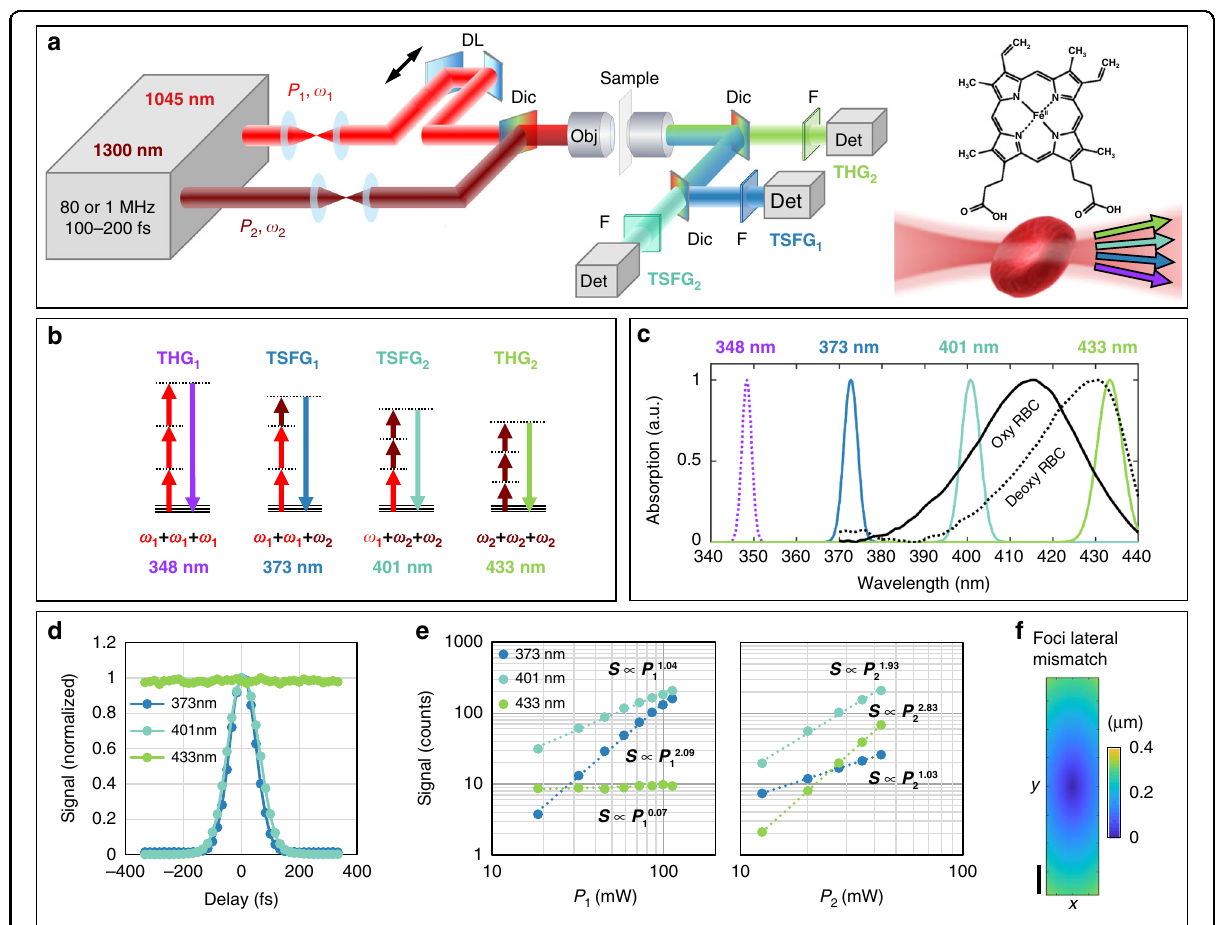
Fig. 1 Principles of color TSFG microscopy for blood imaging. a Experimental setup. DL: motorized optical delay line. Dic: dichroic mirror. Obj: objective lens. F: spectral bandpass fi lter. Det: detector. b Energy diagram of the simultaneous signals processes in color TSFG microscopy, based on third-order combinations of two excitation beams at frequencies ω 1 and ω 2 . The wavelengths indicated are those produced in the case of mixed 1045 and 1300 nm excitation. c Measured linear absorption spectra of zebra fi sh RBCs in deoxygenated (dotted line) and oxygenated (solid line) states. The wavelengths generated simultaneously by color TSFG encompass the Soret absorption band of hemoglobin, enabling spectroscopic measurements. d Measured TSFG 1 , TSFG 2 and THG 2 signals from a water-glass horizontal interface as a function of the temporal delay between the two excitation pulse trains. e Measured TSFG 1 , TSFG 2 and THG 2 signals from polystyrene beads as a function of the excitation power of the pump beam (P 1 ) and OPO beam (P 2 ), consistent with Eq. 1. f Excitation beam foci lateral mismatch along the y -direction, reaching a maximum of 0.4 μ m separation 400 µm away from the optical center. Scale bar: 100 μ m. The measurement is based on data from 424 fl uorescent beads distributed across the fi eld of